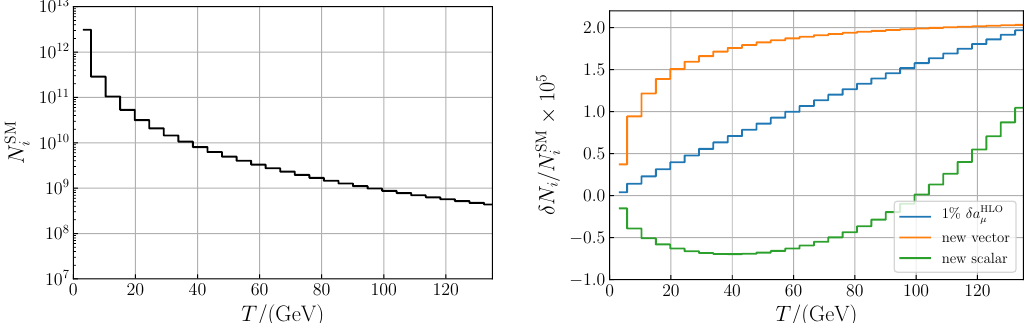
Figure 2 . Left : event distribution as function of electron recoil energy T in the MUonE experiment, computed at the leading-order in the SM. Right : the event excess/de(cid:12)cit ratios caused by 1% larger a had (blue), a t -channel Z 0 boson (cf. section 3.1) with mass m Z 0 = 100 MeV and couplings (cid:22) g e;(cid:22) = 10 (cid:0) 3 (orange), and a t -channel S (cf. section 5.1) with mass m S = 100 MeV and couplings Z 0 y ee;(cid:22)(cid:22) = 2 : 4 10 (cid:0) 2 (cid:2)